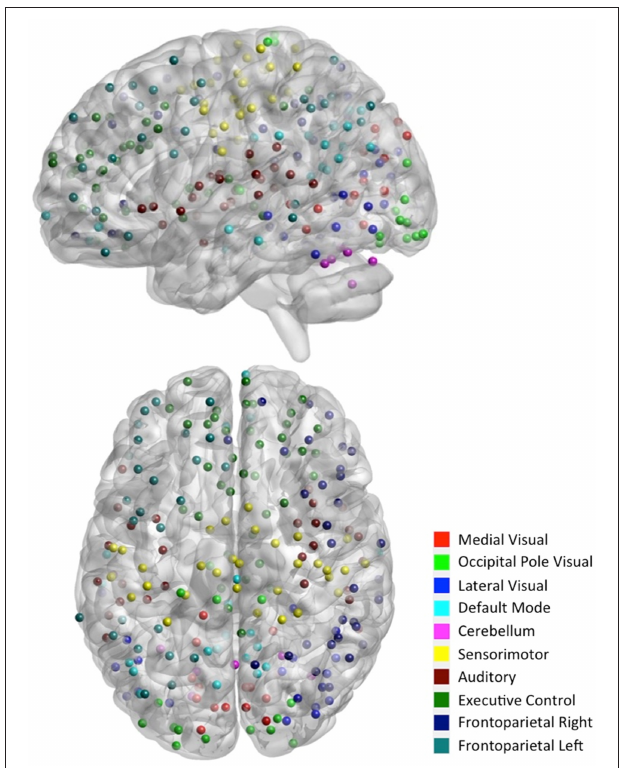
FIGURE 3 | Parcellation scheme and network assignment. The 232 nodes used in our network analysis are adapted from the 264-node parcellation system ( Power et al., 2011). Each node is a 10mm diameter sphere in MNI space representing a putative functional area, and is color-coded to indicate its module membership. Functional modules are defined by 10 primary RSNs (Smith et al., 2009).